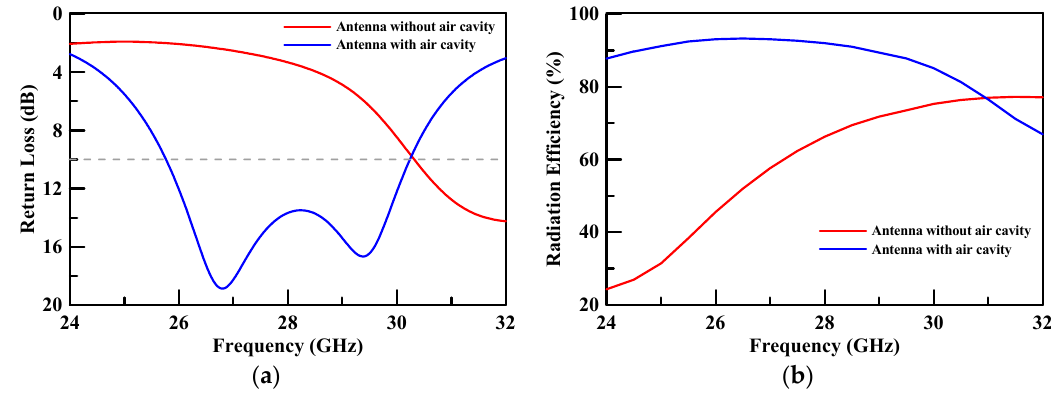
Figure 3. ( a ) The return loss and ( b ) the radiation efficiency of the patch antenna.